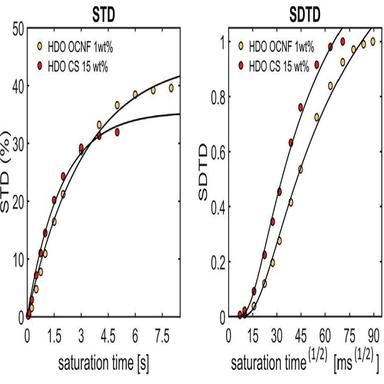
STD (left) and SDTD (right) build–up curves of the HDO peak for the OCNF 1 wt% dispersion (pale yellow) and corn starch (CS) 15 wt% gel (red) prepared in D2O. The mathematical fits to Eq., using a fixed grid spacing (r) of 2 Å, are shown. A b value of 1 was used for both SDTD curves. (For interpretation of the references to colour in this figure legend, the reader is referred to the web version of this article.)